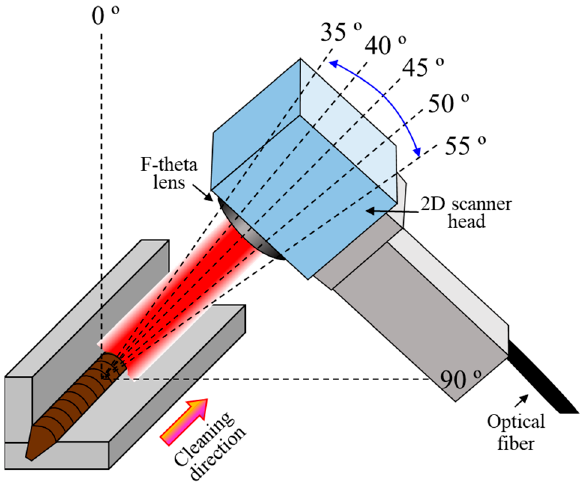
Figure 8. Schematic of fillet weld laser cleaning experiment method according to laser head tilt angle.